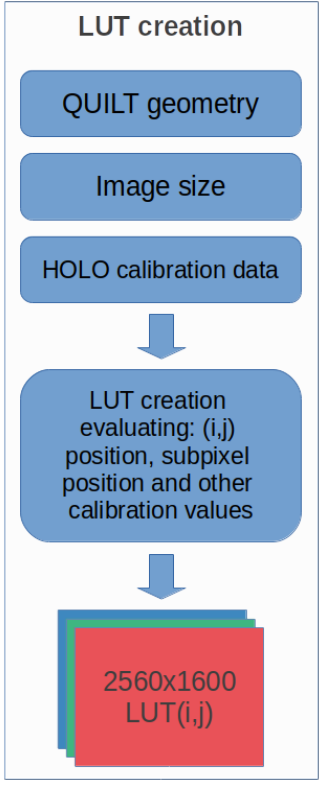
Figure 6. Basic steps of our LUT